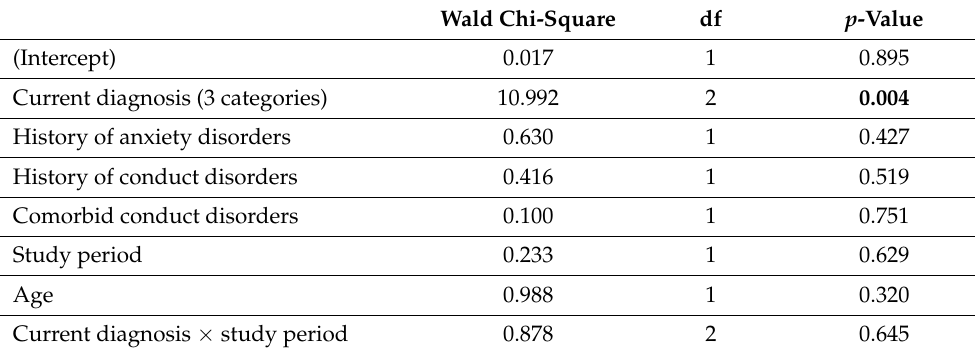
Table 2. Generalized linear model (GLM) summary statistics performed on Beck’s Suicidal Intent Scale (SIS). Significant effect of continuous or categorical predictors are reported in bold.